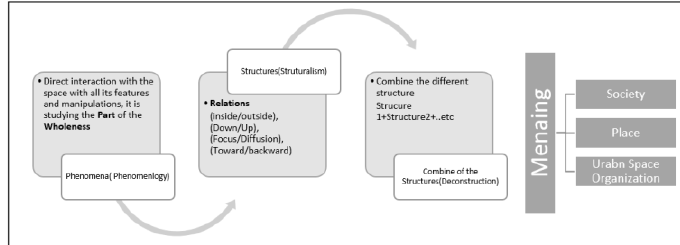
Figure 1. Methodology. Source: Developed by the